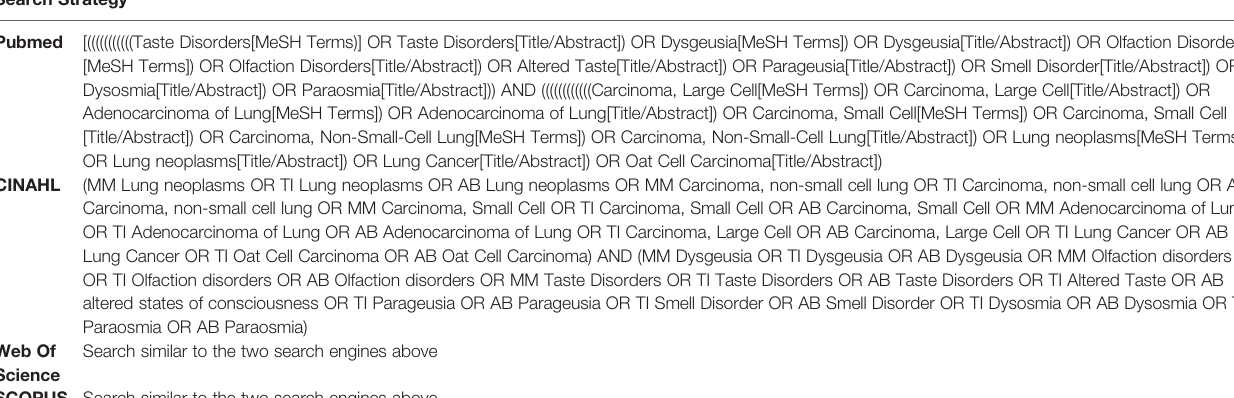
TABLE 1 | Summary of the search